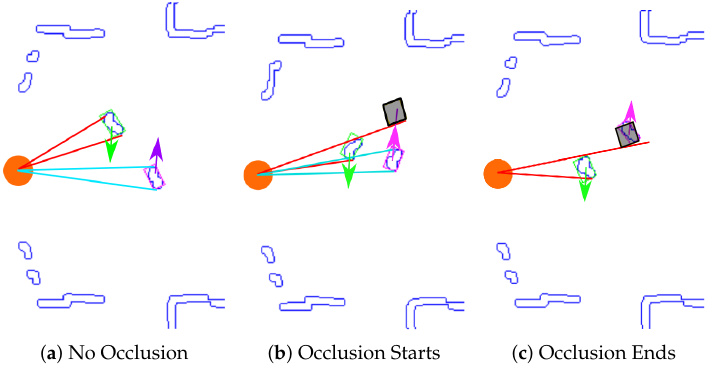
Figure 4. Dynamic Occlusion Detector: different stages.